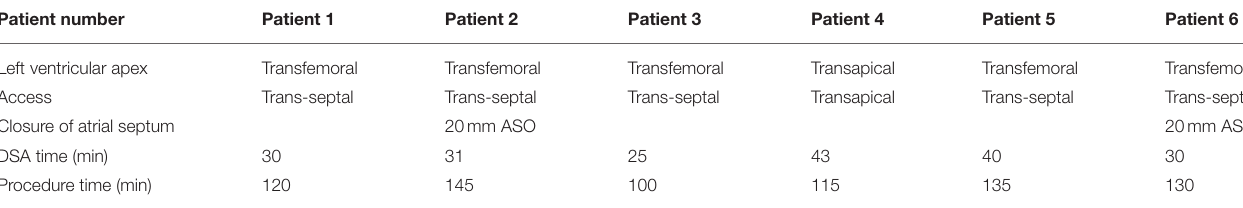
TABLE 4 | Patients undergoing transcatheter mitral valve implantation using trans-septal access or transapical access. Patient number